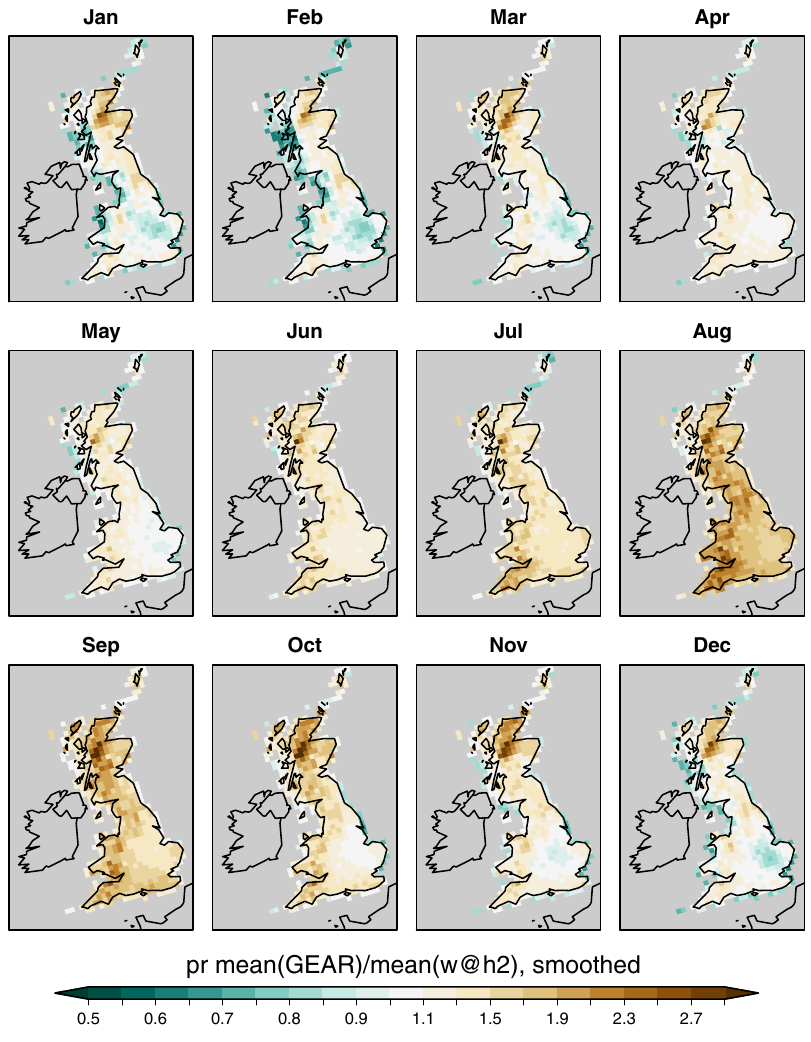
Figure 5. Bias-correction multiplicative factor applied to precipitation. A spatial smoothing was applied to the monthly ratios between observed (GEAR) and modelled (w@h2) 1961–2006 precipitation (see Fig. S5 for the unsmoothed